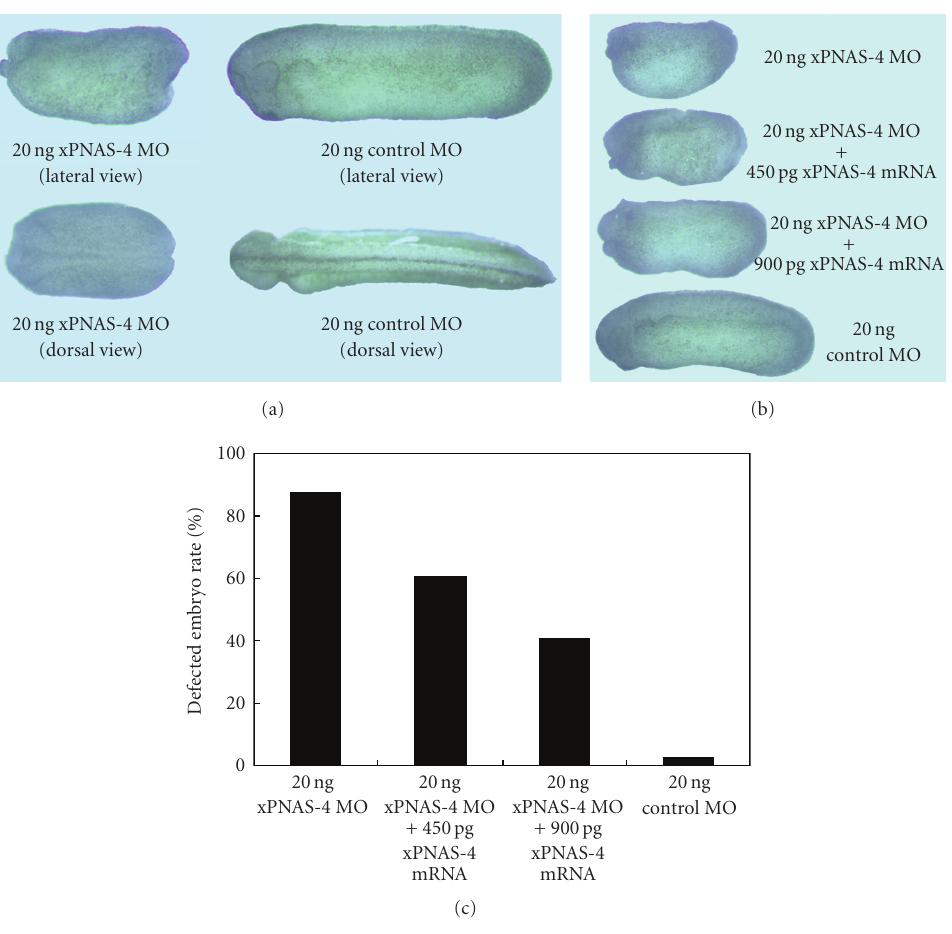
Figure 5: E ff ect of xPNAS-4 MOs microinjection. (a) Embryos microinjected with 20ng of xPNAS-4 MO exhibited failure of head development and shortened axis defects (left), but embryos microinjected with 20ng of control MO embryos were normal (right). (b) The embryos were partially rescued by co-injected with 450 pg of xPNAS-4 mRNA and 20ng of xPNAS-4 MO (the second row) in comparison with embryos microinjected with 20ng of xPNAS-4 MO alone (the first row). Better rescue was observed after co-injection of 20ng of xPNAS-4 MO plus 900 pg of xPNAS-4 mRNA (the third row). The fourth row shows a normal embryo microinjected with 20 ng of control MO. (c) The rate of defective embryos seen in the